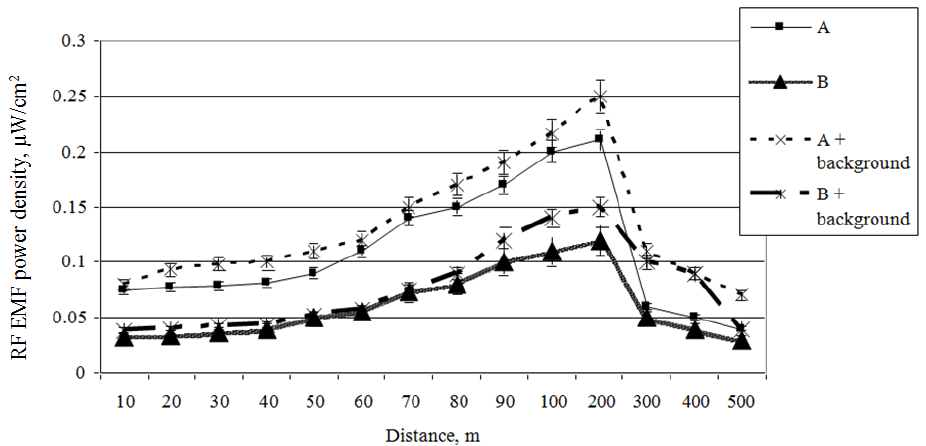
Figure 11. Contributions of different antenna types to the total exposure.